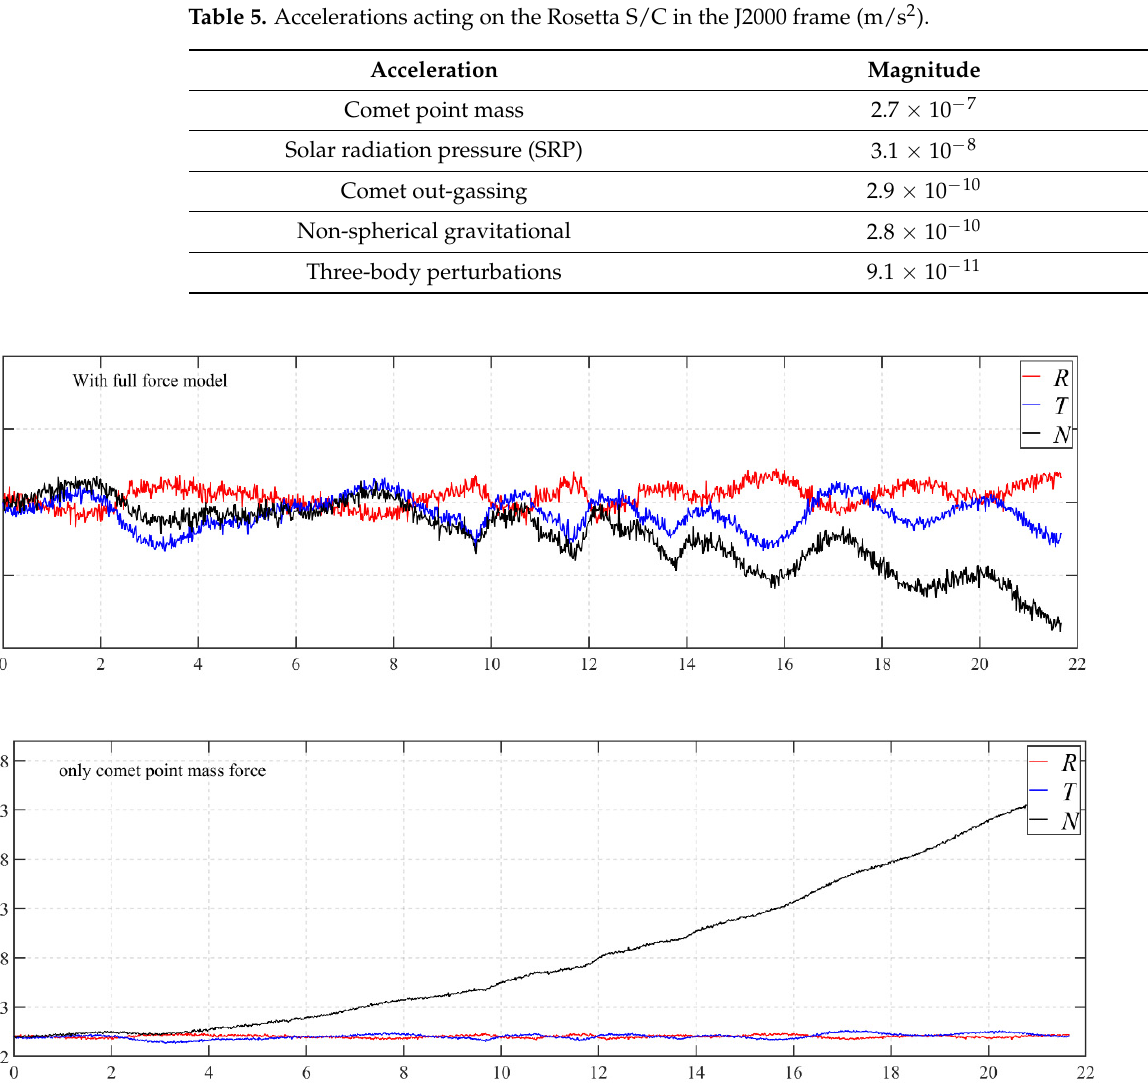
Figure 3. Rosetta S/C differences in position between the integrated orbit computed in this paper and the ESOC nominal orbit in the comet-centered J2000 frame over the 22 min of the acquisition sequence, along the Radial, along-track (Transverse) and cross-track (Normal) directions. For the upper graph, a full forces model (case 1) was used, while for the lower graph, only a point mass was used (case 2). With a full-forces model, the discrepancies are under 2 mm; with the point-force model, the position error is mainly along the cross-track (N) direction, but still less than 30 mm after 22 min. In Table 6, we list the a priori values of the parameters related to the model of CON- SERT direct range and their errors. For the comet 67P/C-G rotation model, we used the numerical quaternions contained in the CK kernel (CATT_DV_145_02_______00216.BC), produced by the ESOC/Flight Dynamics (FD). Due to the complexity of comet rotation, linked to outgassing, it is difficult to describe, over long periods of time, the comet rotation with the standard IAU formulation. The uncertainty in RA (±0.05°) and DEC (±0.03°) pro- vided in Table 6 for the comet rotation axis have the same level of influence as the Philae lander position uncertainties (i.e., around 2 m).